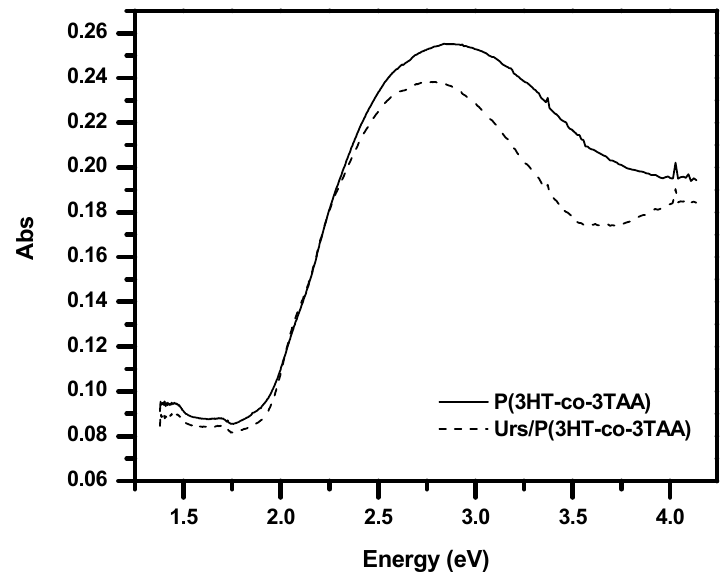
Figure 5. UV-visible absorption spectra of P(3HT- co -3TAA) and Urs/P(3HT- co -3TAA).